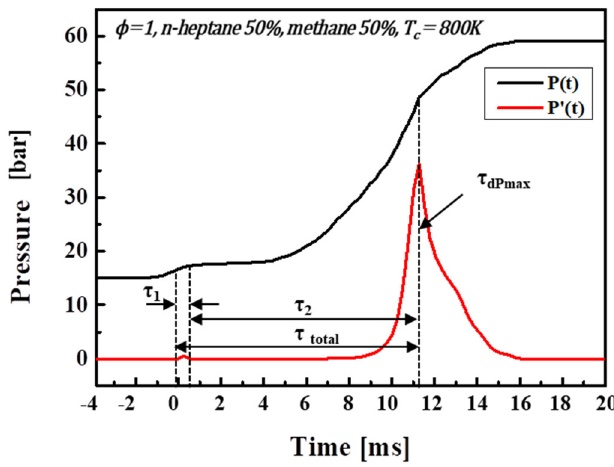
Figure 2. Schematic of ignition delay time.